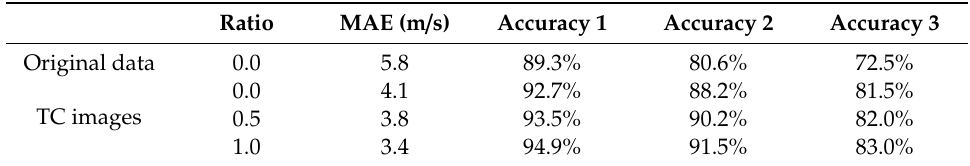
Table 6. Performance evaluation with di ff erent data augmentation ratios (the di ff erent accuracy metrics correspond to the three sets of classification criteria in Table